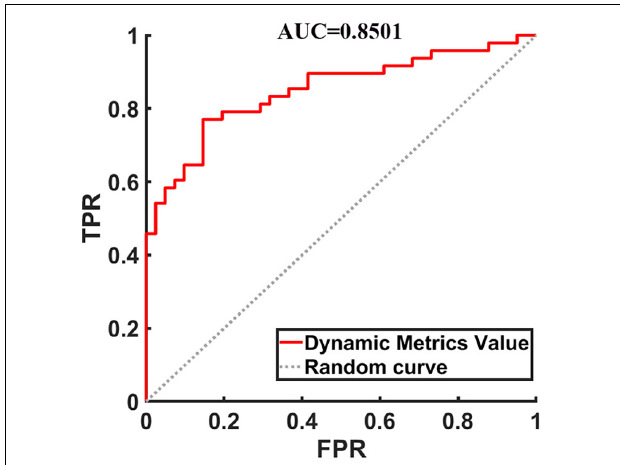
FIGURE 2 | The receiver operating characteristic curve of dynamic metrics. The image of ROC was displayed using MATLAB software. FPR, false positivity rate; TPR, true positivity rate; AUC, area under the receiver operating characteristic curve.